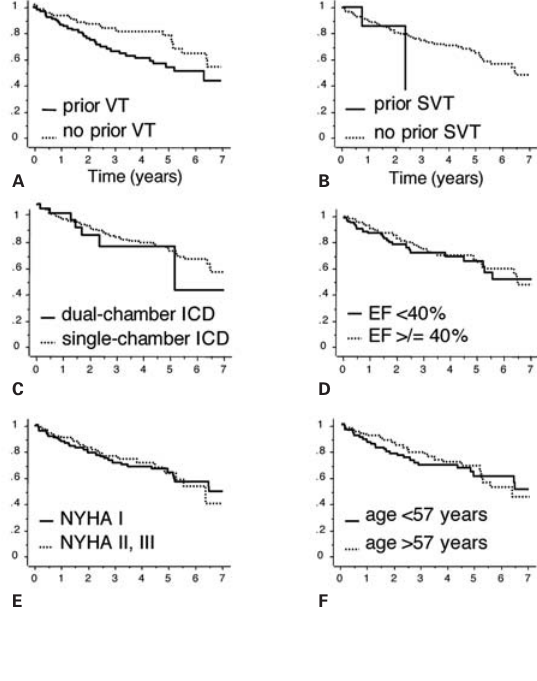
ter (n = 35, 44%) and sinus tachycardia (n = 26, 32%); other frequent reasons for inappropriate